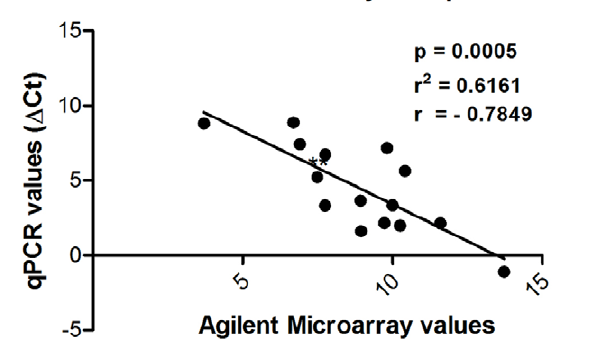
Figure 11. Linear regression analysis revealed a good degree of correlation (R 2 =0.6161) between oligonucleotide microar- ray and quantitative RT-PCR. Horizontal axis, values obtained with microarray experiments; vertical axis, values obtained with